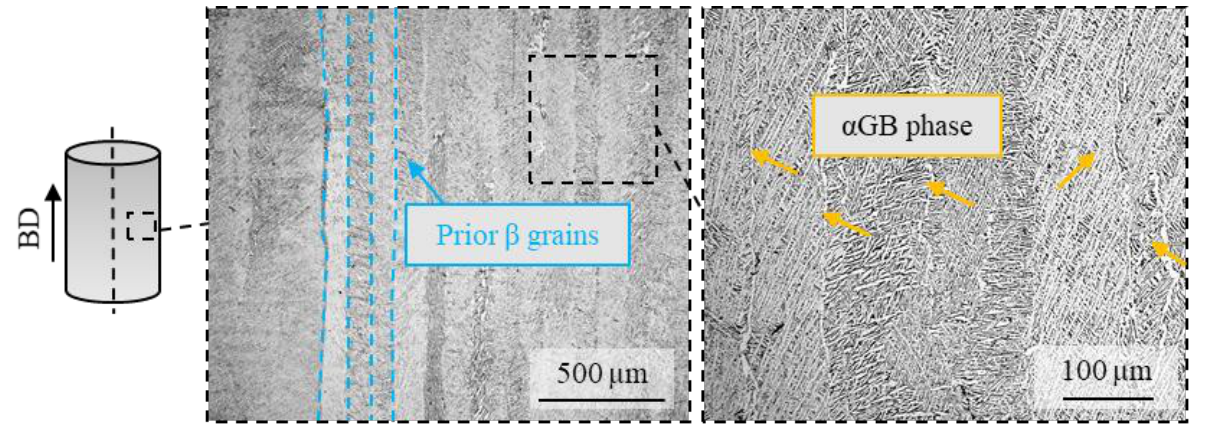
Figure 2. LPBFed Ti6Al4V microstructure at different magnifications (BD stands for building direction). Table 3. Mean grain size and micro-hardness of the LPBFed Ti6Al4V samples.